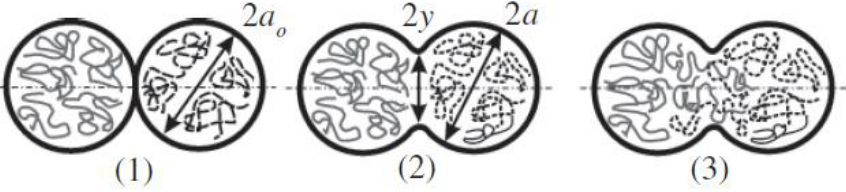
Figure 2. Formation of the neck between filaments: ( 1 ) surface contacting, ( 2 ) neck growth, and ( 3 ) diffusion at interface, Reprinted with permission from [24], 2004, Elsevier, Amsterdam, The Neth- erlands.